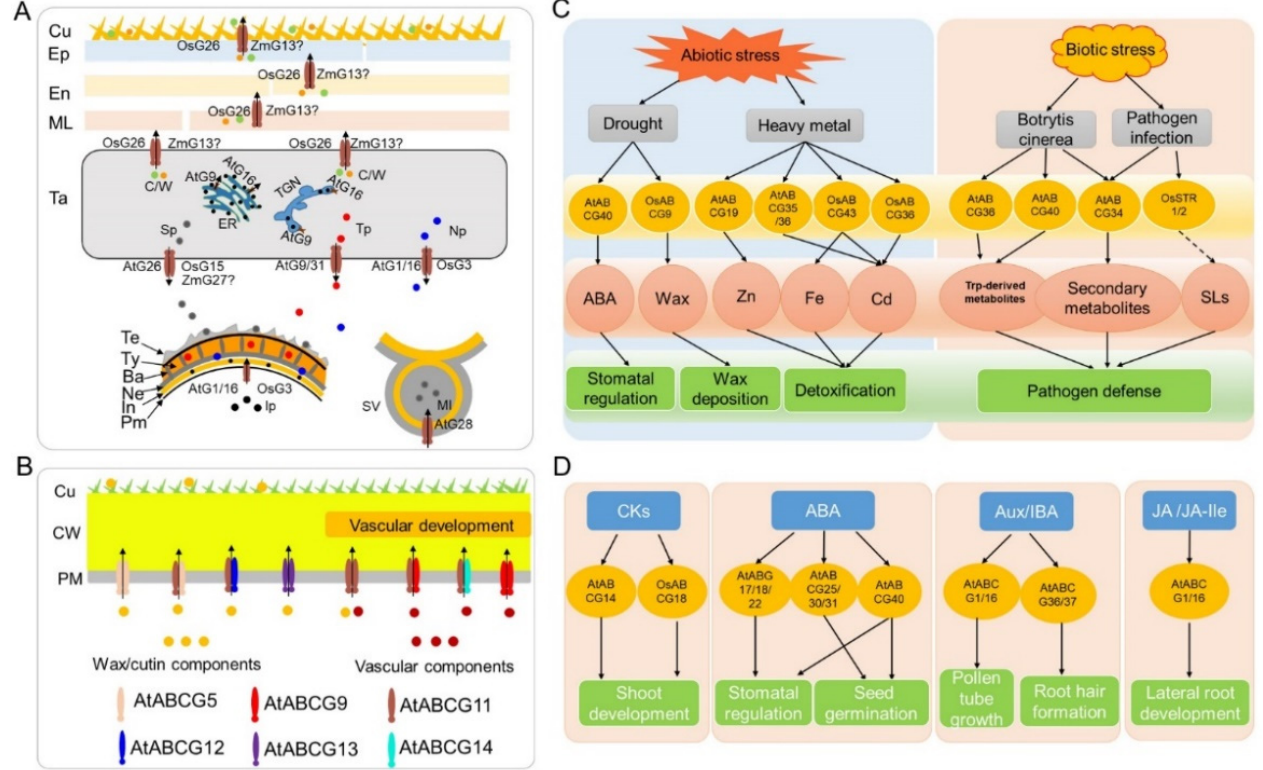
Figure 3. The main functions of ABCG transporters in Arabidopsis , rice and maize. ( A ) The proposed working model of ABCG transporters involved in anther and pollen development. Several ABCGs transfer tapetum-generated lipidic and other precursors for anther cuticle and pollen wall development, and AtABCG28 is required for the apical accumulation of reactive oxygen species in growing pollen tubes. AtG, AtABCG; Ba, baculum; Cu, cuticle; C/W, cutin and wax; Ep, epidermis; En, endothecium; In, intine; Ip, intine precursors; MI, membrane lipids; ML, middle layer; Ne, nexine; Np, nexine precursors; Pm, plasma membrane; Sp, sporopollenin precursors; SV, secretory vesicle; Ta, tapetum; Te, tectum; TGN, trans-Golgi network; Ty, tryphine; Tp, tryphine precursors; ZmG, ZmABCG. ( B ) The working model of ABCG transporters contributed to the formation of a tight cuticle layer and vascular development in Arabidopsis . The homodimers of AtABCG5/AtABCG5, AtABCG11/AtABCG11, and AtABCG13/AtABCG13, and the heterodimers of AtABCG11/AtABCG5 and AtABCG11/AtABCG12 transfer wax/cutin components for the formation of tight cuticle layers. The homodimers of AtABCG11/AtABCG11 and AtABCG9/AtABCG9, and the heterodimers of AtABCG11/AtABCG9 and AtABCG11/AtABCG14 transport vascular components for vascular development. Cu, cuticle; CW, cell wall; PM, plasma membrane. ( C ) Regulation of plant resistance by ABCG transporters in response to biotic and abiotic factors. The stress factors, ABCG transporters and their corresponding substrates and physiological roles in plants, are displayed in ( C ). ABA, abscisic acid; SLs, strigolactones. ( D ) Hormone transport and signaling of ABCG transporters. The hormone, ABCG transporters and their biological functions are displayed in ( D ). CKs, cytokinins; ABA, abscisic acid; Aux, Auxin; IBA, indole-3-butyric acid; JA, jasmonic acid; JA-Ile, jasmonic acid- isoleucine.